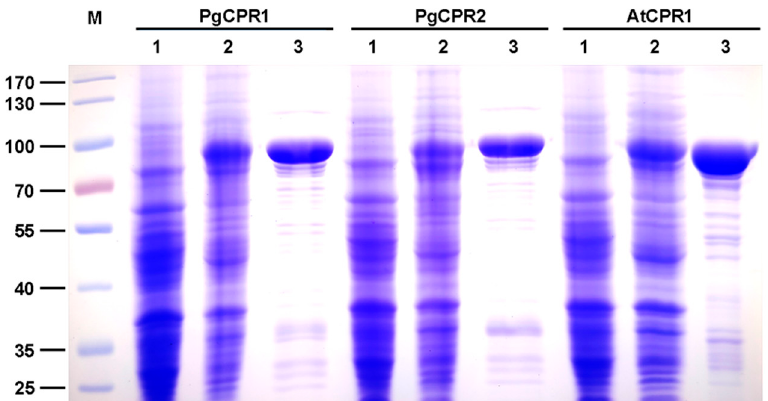
Figure 3. Expression and purification of recombinant PgCPRs and AtCPR1. The SDS-PAGE analysis of PgCPRs and AtCPR1 stained with Coomassie blue R-250. Lane M: protein marker; Lane 1: The crude enzyme in BL21 without IPTG. Lane 2: IPTG induced crude enzyme; Lane 3: The purified protein with his-tag. Table 1. Specific activities of recombinant CPRs in reducing cytochrome c (100 μ mol/L) with 100 μ mol/L of NADPH or NADH. All data represent means ± standard deviations (SD). ND: Not detectable.